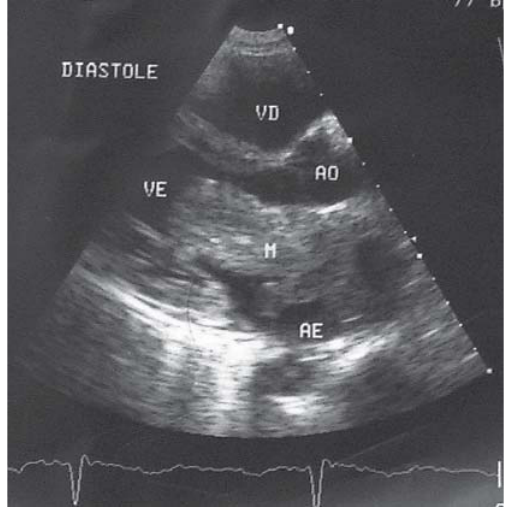
Fig. 1 - Two dimensional echocardiogram test during diastole showing the tumor projecting into the left ventricle. Ao = aorta; VD = right ventricle; VE = left ventricle; M = tumor mass; AE = left atrium